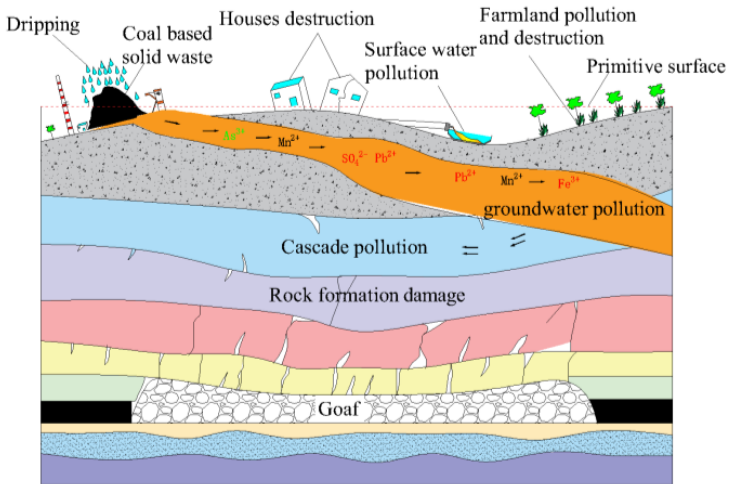
Figure 1. Ecological and environmental problems caused by large-scale mining of coal resources.